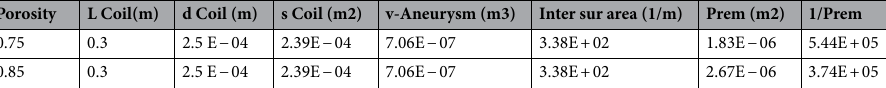
Table 1. Details of applied coiling for selected MCA